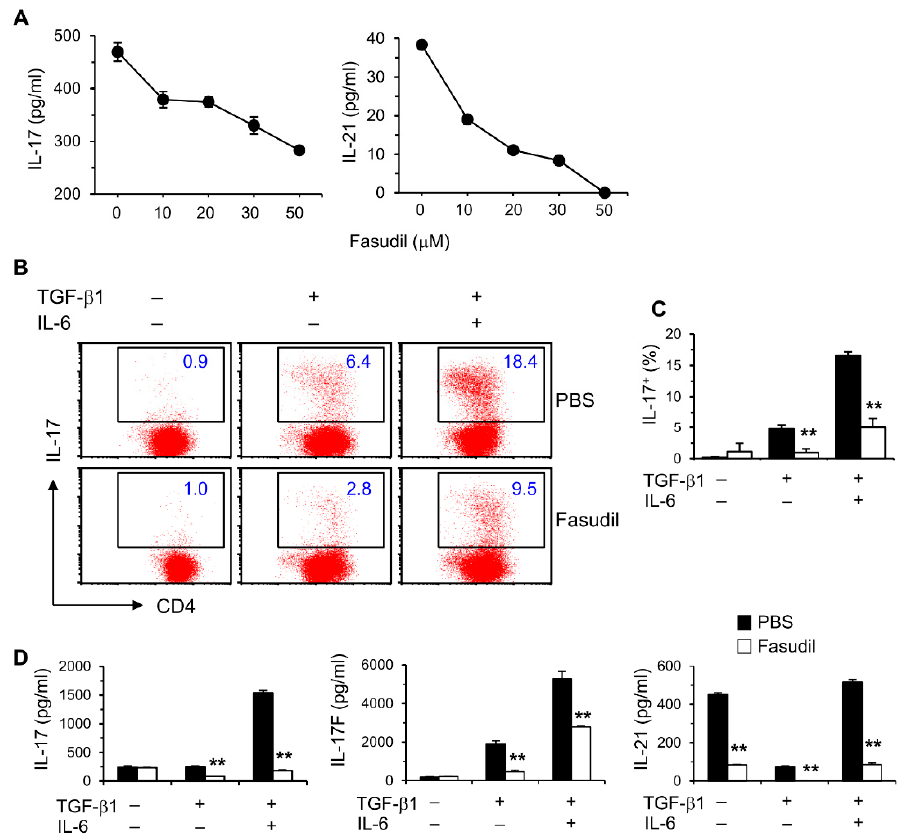
Figure 3. Fasudil blocks Th17 di ff erentiation. ( A ) Naïve CD4 + T cells pooled from 8 mice were stimulated with anti-CD3 / CD28 for two days without or with fasudil (0–50 µ M). Interleukin (IL)-17 and IL-21 in the culture supernatants were determined by ELISA. ( B , D ) Naïve CD4 + T cells were di ff erentiated under Th17 / Treg conditions for four days and restimulated with PMA plus ionomycin for five hours in the presence of vehicle (PBS) or fasudil (30 µ M) throughout the culture. Cells were collected for IL-17 intracellular staining. Percentages of IL-17 + CD4 + T cells are shown ( B ) in representative dot plots and ( C ) summarized in a bar graph. ( D ) IL-17, IL-17F, and IL-21 in the culture supernatants were determined by ELISA. Data (mean + SD of triplicates) are representative of two independent experiments. ** p < 0.01 compared with PBS-treated groups.